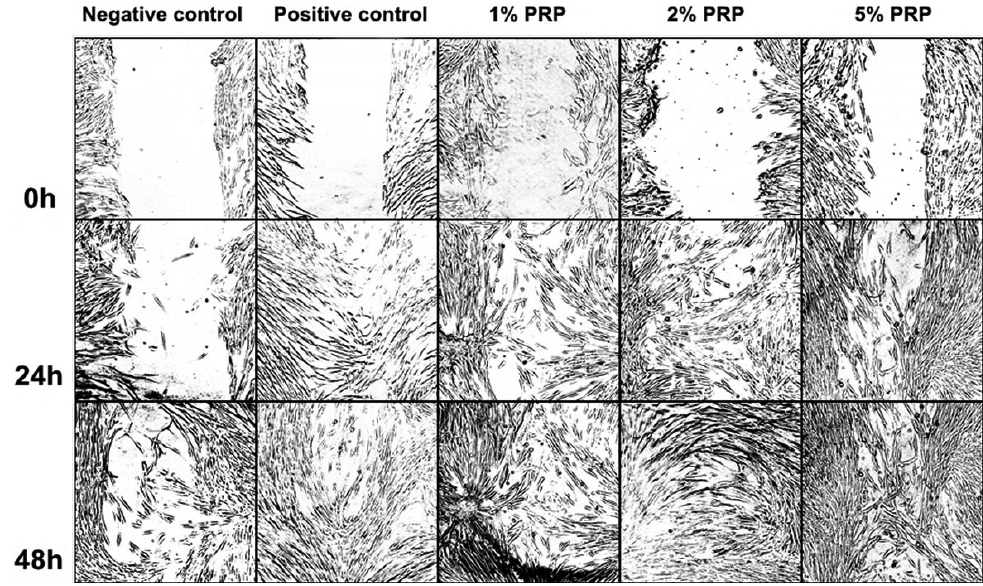
Figure 5- Scratch assay at 0, 24 and 48 hours (h) (Original magnification of these graphs was x10)